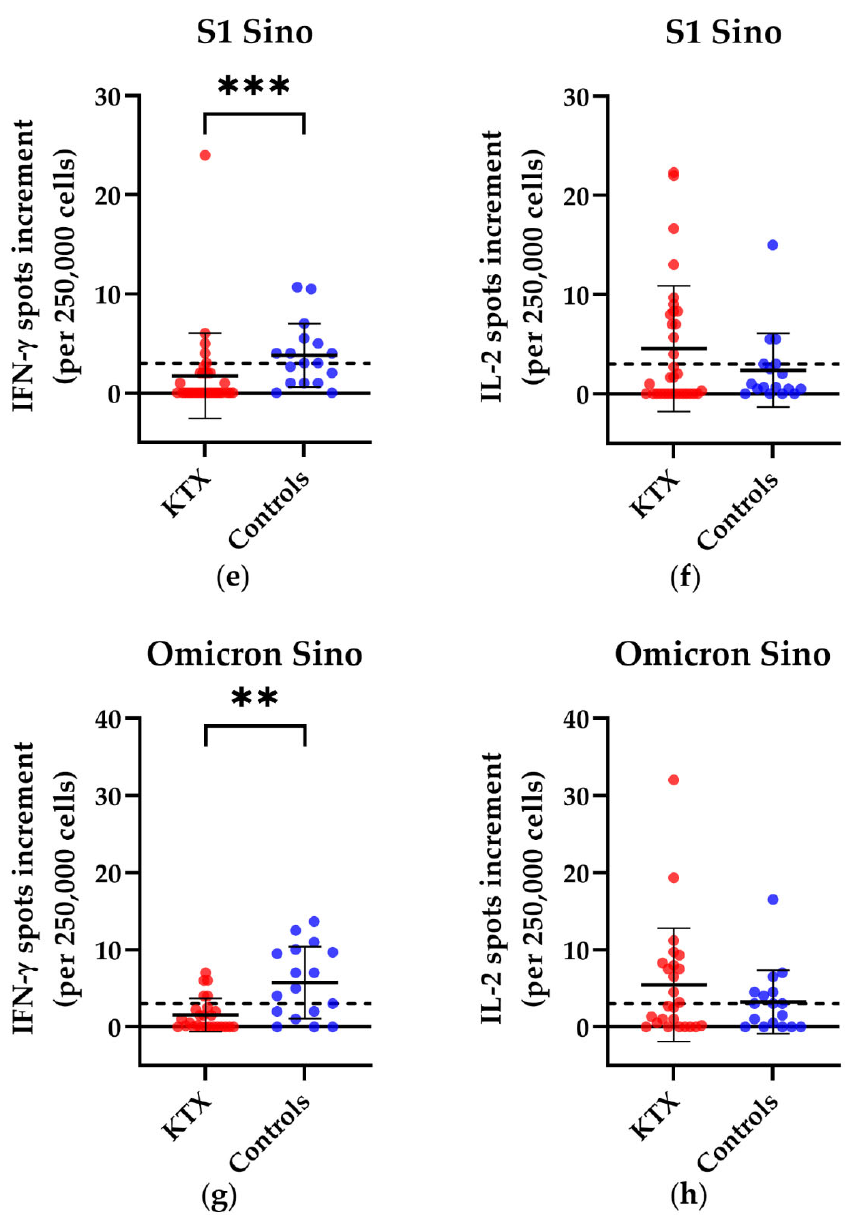
Figure 2. SARS-CoV-2-specific responses in kidney transplant (KTX) patients and healthy controls after booster vaccination, using our in-house ELISpot assay. Distribution of ( a ) IFN- γ and ( b ) IL-2 ELISpot responses after stimulation with an S1/S2 peptide mix, with an S1 peptide mix ( c , d ), S1 Sino ( e , f ) and S1 Sino of the omicron variant ( g , h ). Red circles show data of the KTX patients, while blue circles indicate data of the healthy volunteers. Two-tailed Mann–Whitney tests were used to compare the responses (** p < 0.01, *** p < 0.001, **** p < 0.0001). Mean values are represented by horizontal lines, while the standard deviation is represented by error bars. The horizontal line shows the zero line. The dashed line indicates the cut ‐ off.